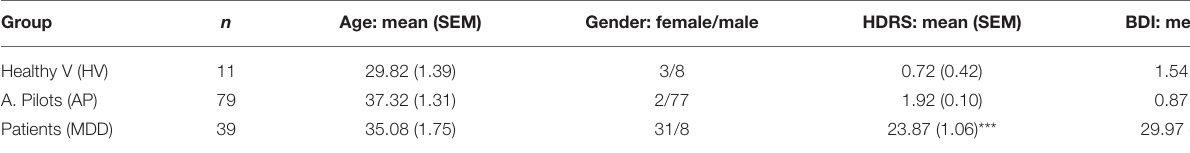
TABLE 1 | Demographic data and psychiatric tests of healthy volunteers, Airline pilots, and MDD patients. Group